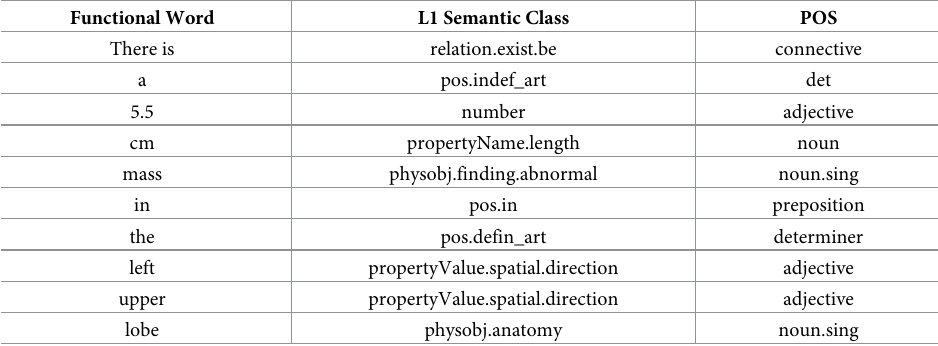
Table 1. Example of functional word features as assigned to sentence Ex-1 during the lexical analysis